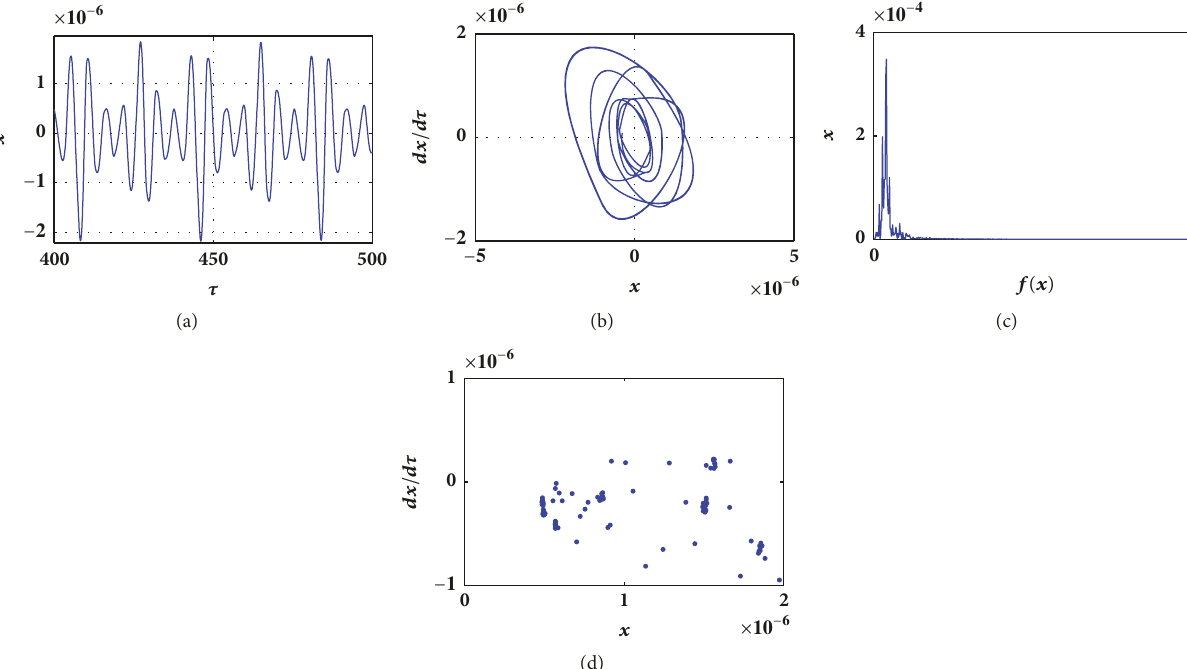
bands slide with a lower sliding speed for a smaller 𝑇 =